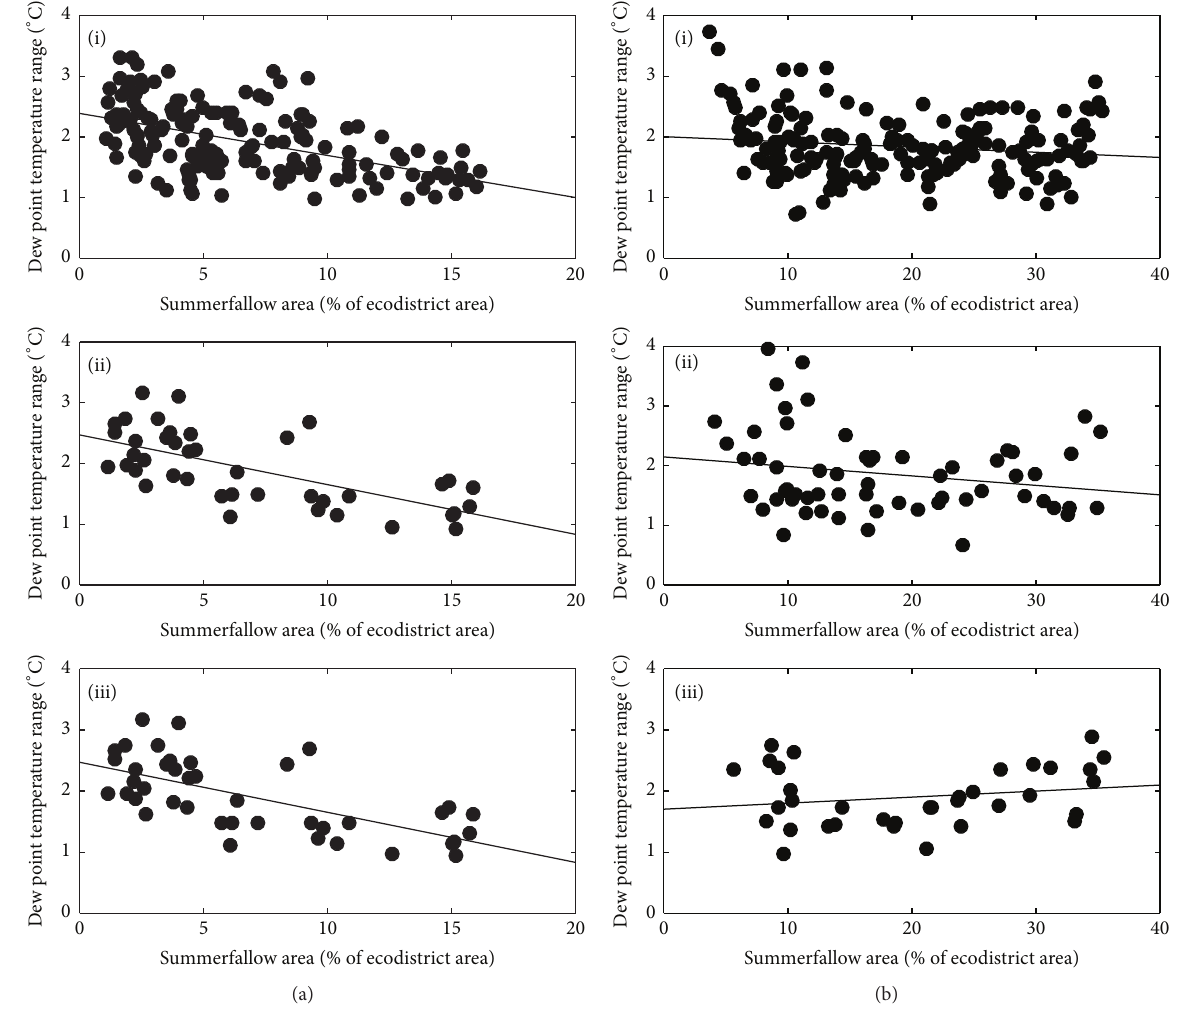
Figure 5: Relationship between the percentage of summerfallow area and seasonal average range of daily dew point temperature (early morning minimum to late morning maximum) from 1961 to 2006 for (a) subhumid and (b) semiarid climatic zone for precipitation regimes, namely, (i) normal years, (ii) wet years, and (iii) dry years.